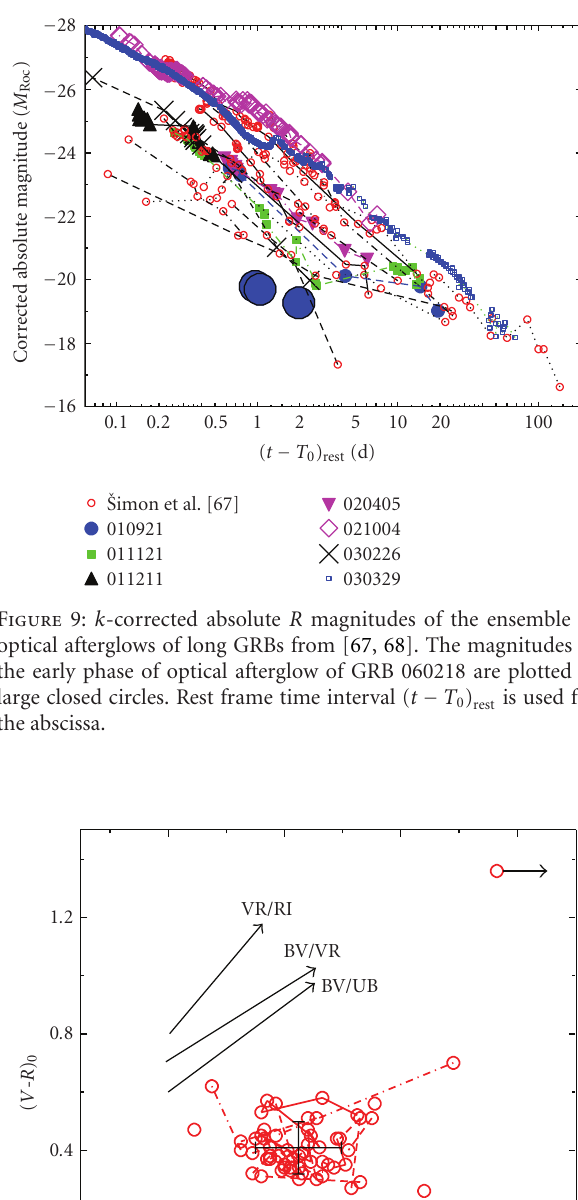
Figure 10: Color-color ( B-V versus V-R ) diagram of optical afterglows of long GRBs. The color indices were corrected for the Galactic reddening. Multiple indices of the same optical afterglow are connected by lines for convenience. Optical afterglows of the ensemble [67, 68] are denoted by open red circles. The mean colors (centroid) of the whole ensemble, including the standard deviations, are marked by the large cross. The outlying optical afterglow of GRB 060218 (closed blue circles) is not included in the calculation of the centroid. The representative reddening paths for E B - V = 0 . 5 are shown. Adapted from [67, 68], where a detailed information can be